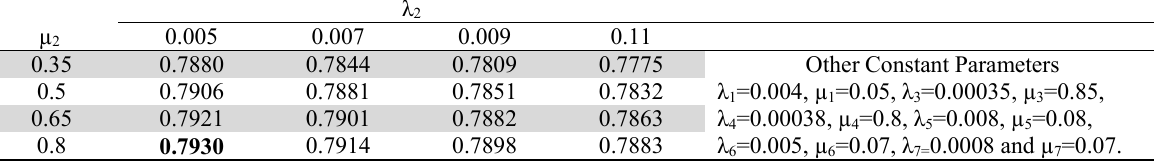
Effect of failure and repair rates of coding machine on system availability µ 3